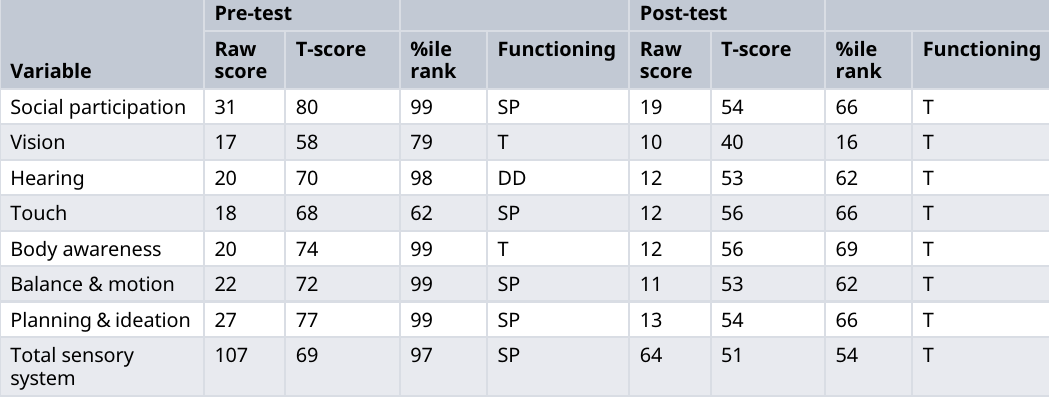
Table 2. Pre- and post-intervention Arabic Sensory Processing Measure-Preschool (SPM-P) school form scale scores.